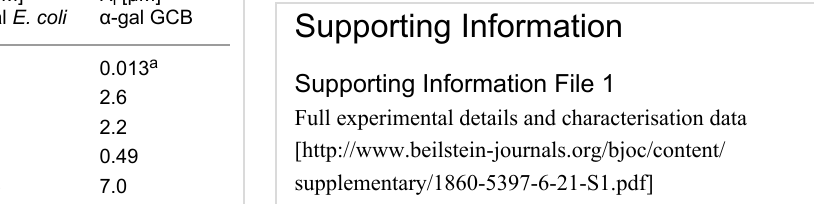
Table 1: Inhibitory activities of compounds 16 – 20 and 22 with β -glyc- osidases from Agrobacterium sp. ( β -glu/gal Abg), E. coli ( β -gal E. coli ) as well as with the α -galactosidase from green coffee beans ( α -gal GCB).